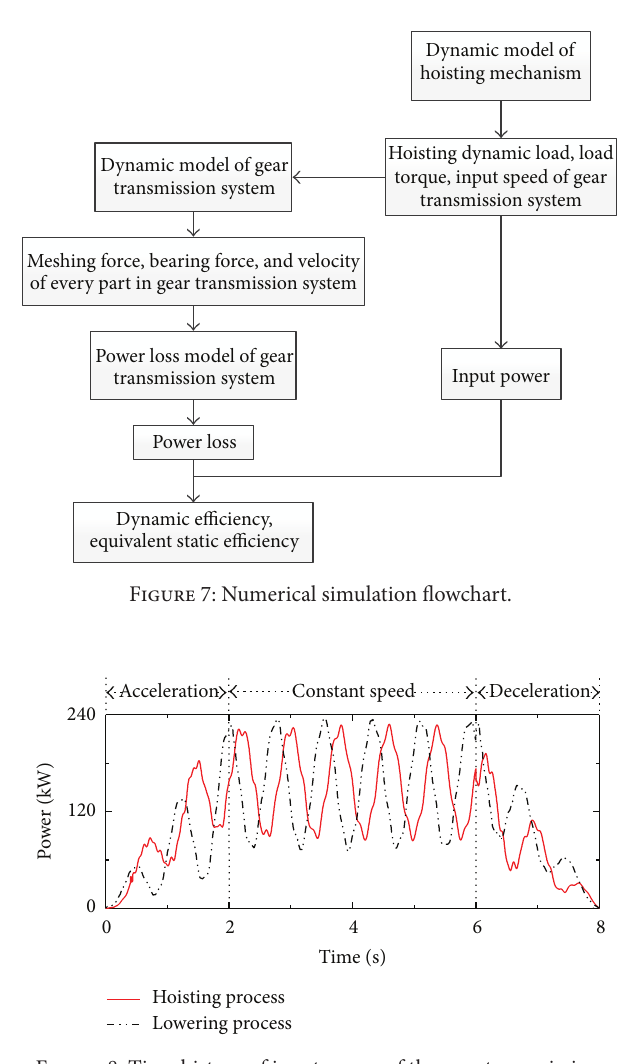
difference of power curve between hoisting and lowering process is the same with the load torque.